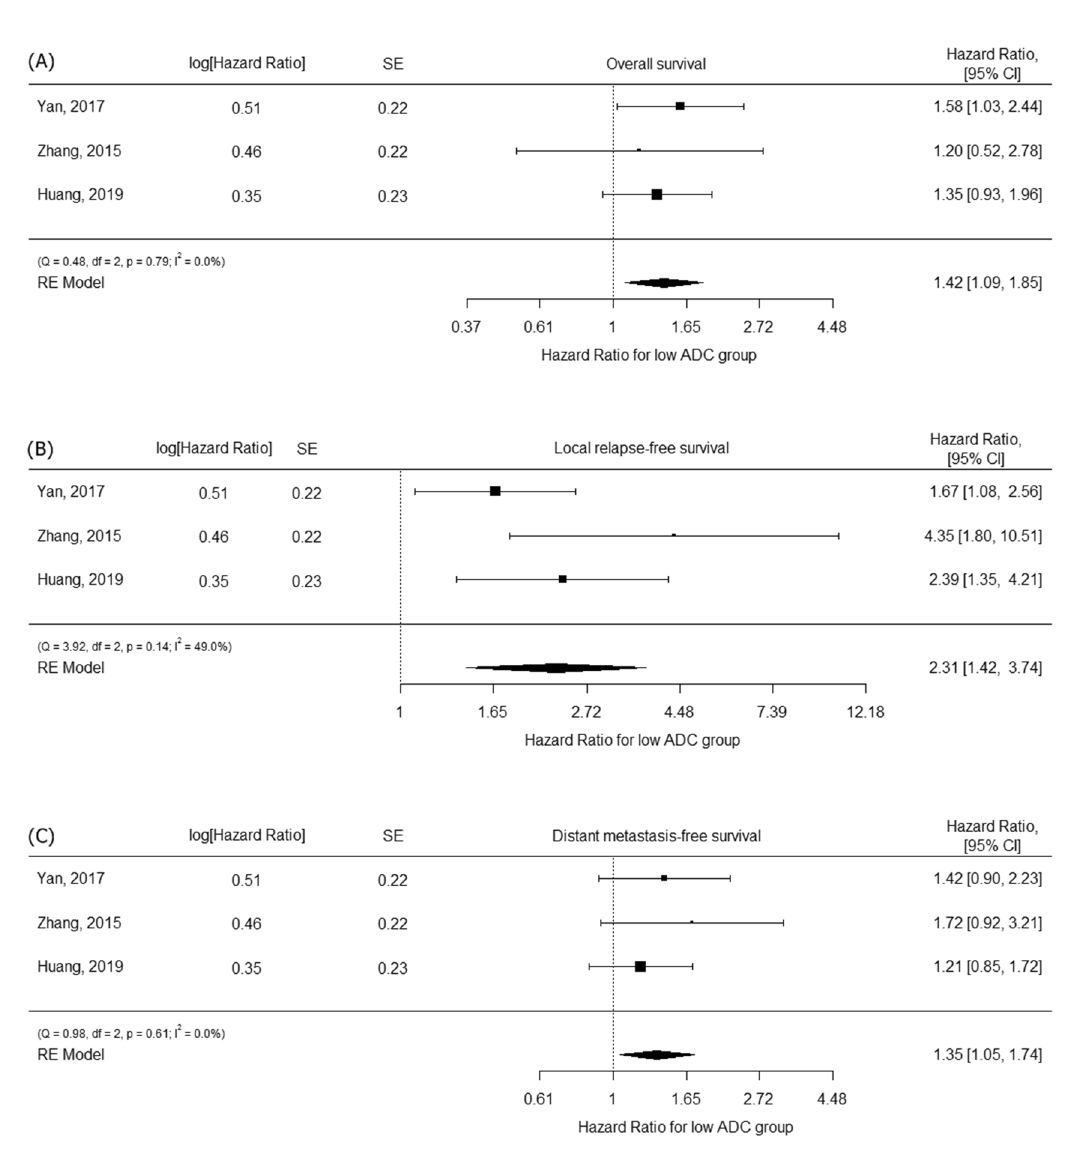
Figure 4. Forest plots for HRs of ( A ) overall survival, ( B ) local relapse-free survival, and ( C ) distant metastasis- free